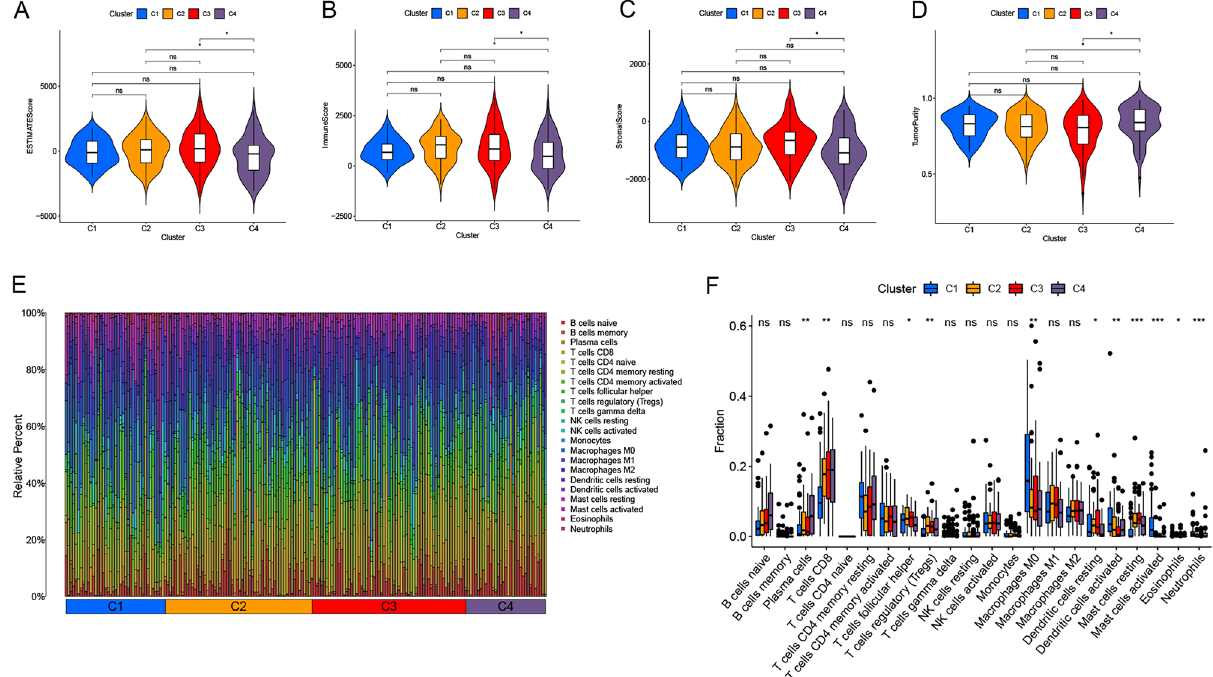
Figure 4. Correlation of immune scores and matrix scores and analysis of immune cell infiltration. ( A ) ESTIMATEScore; ( B ) ImmuneScore; ( C ) StromalScore; ( D ) TumorPurity; ( E ) Heat maps of principal component analysis for the immune cell infiltration among the four types; ( F ) Differential analysis of immune cell infiltration distribution among the four types.